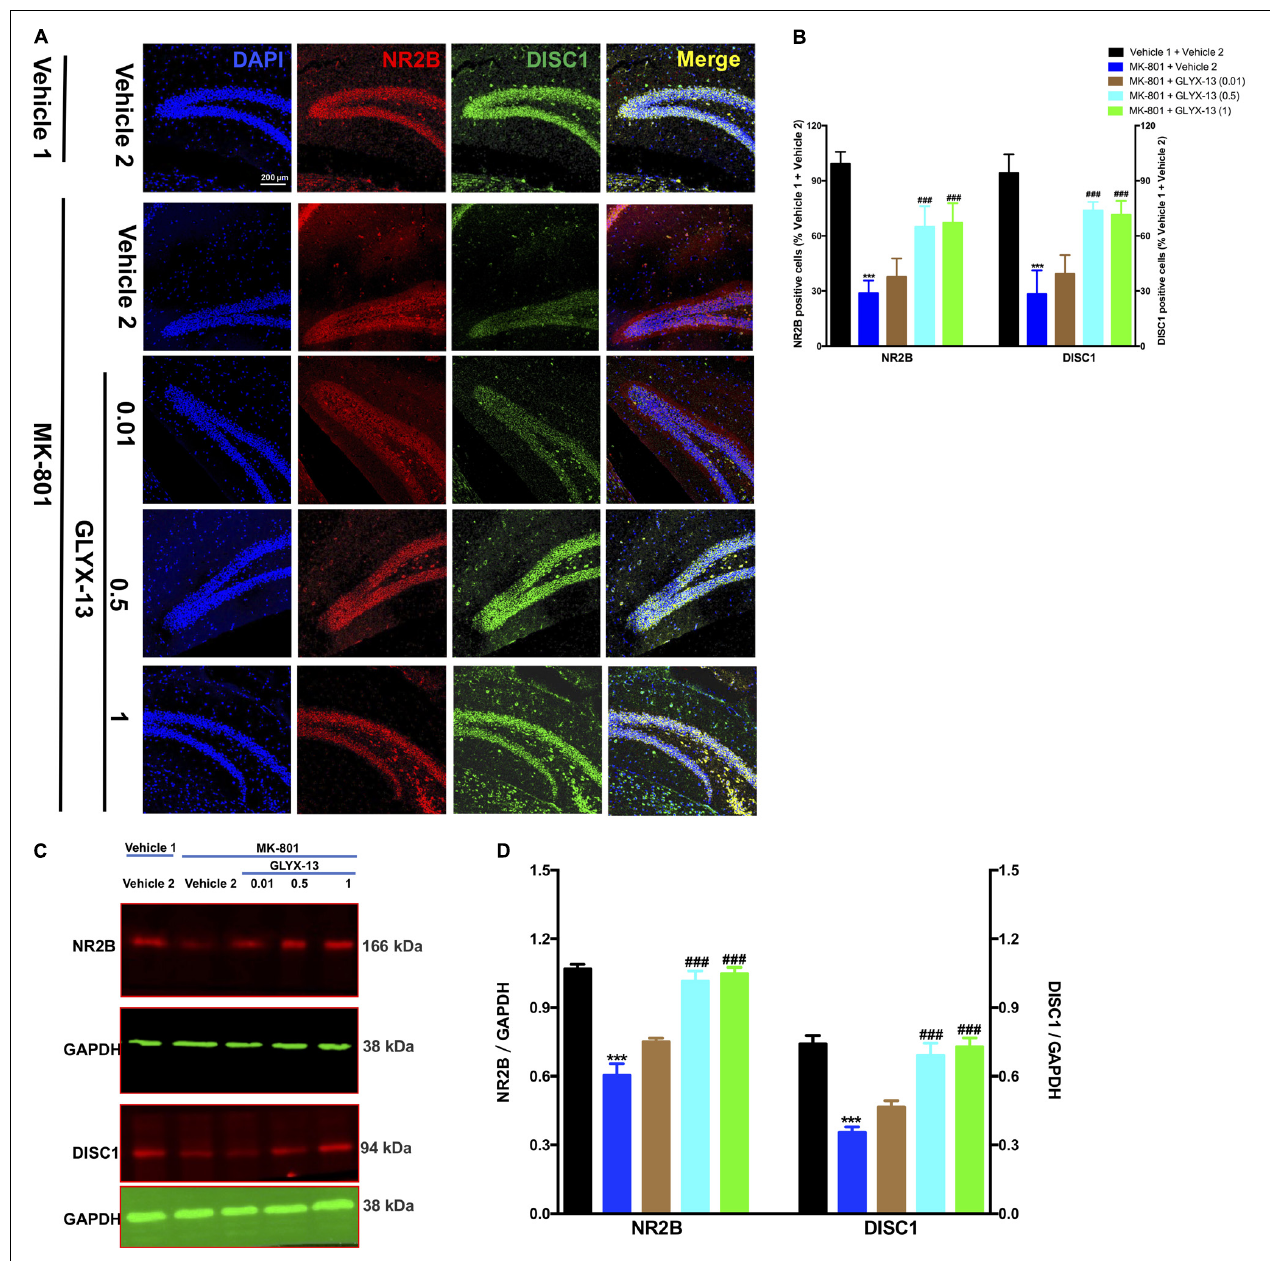
FIGURE 4 | GLYX-13 restored the decrease in NR2B and DISC1 expressions in the dentate gyrus. (A) Confocal microscopy images show double staining for NR2B (red) or DISC1 (green) and merged images in hippocampal slices. Scale bar = 200 µ m. (B) Quantitative analyses of NR2B and DISC1-immunopositive cells in the DG. (C,D) Representative images of immunoblots using antibodies against NR2B and DISC1 along with quantitative analyses. Data are expressed as the mean ± SEM ( n = 6 per group for immunofluorescent analysis and n = 3 per group for western blotting; ∗∗∗ P < 0.001 compared with the vehicle 1 + vehicle 2 group; ### P < 0.001 compared with the MK-801 + vehicle 2